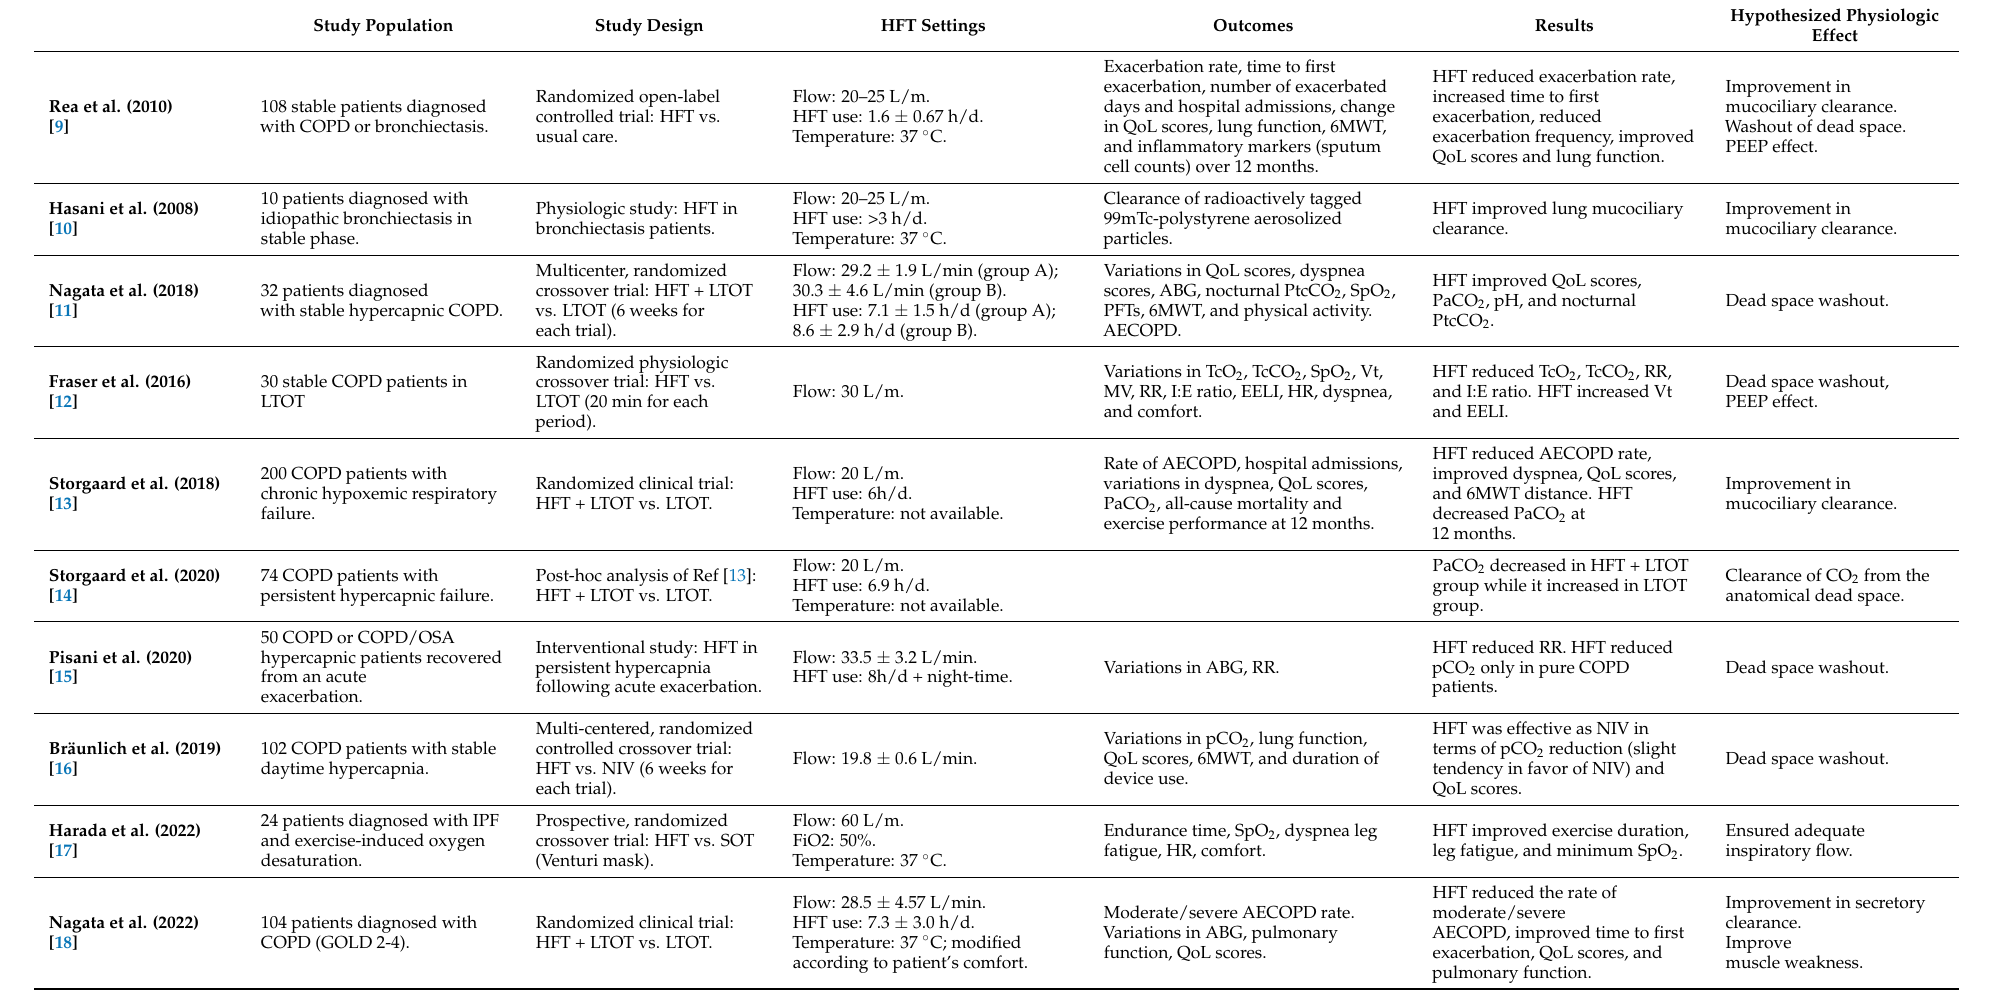
Table 1. HHFT studies cited in the